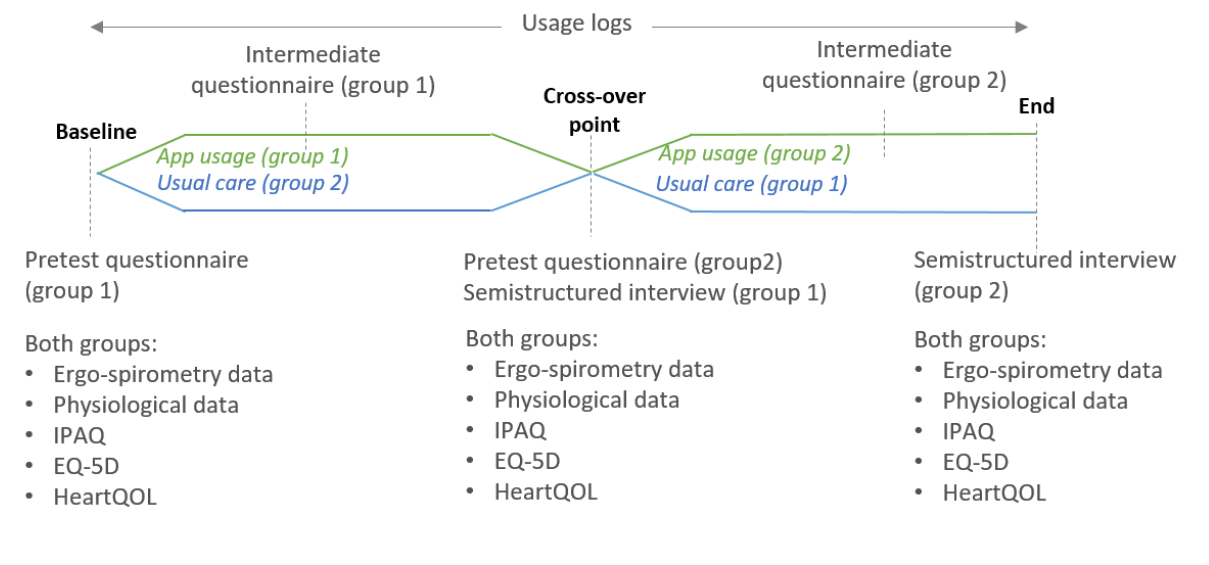
Figure 2. Qualitative and quantitative data collected across different time points of the study. IPAQ: International Physical Activity Questionnaire; EQ-5D: EuroQol 5-Dimensions questionnaire.